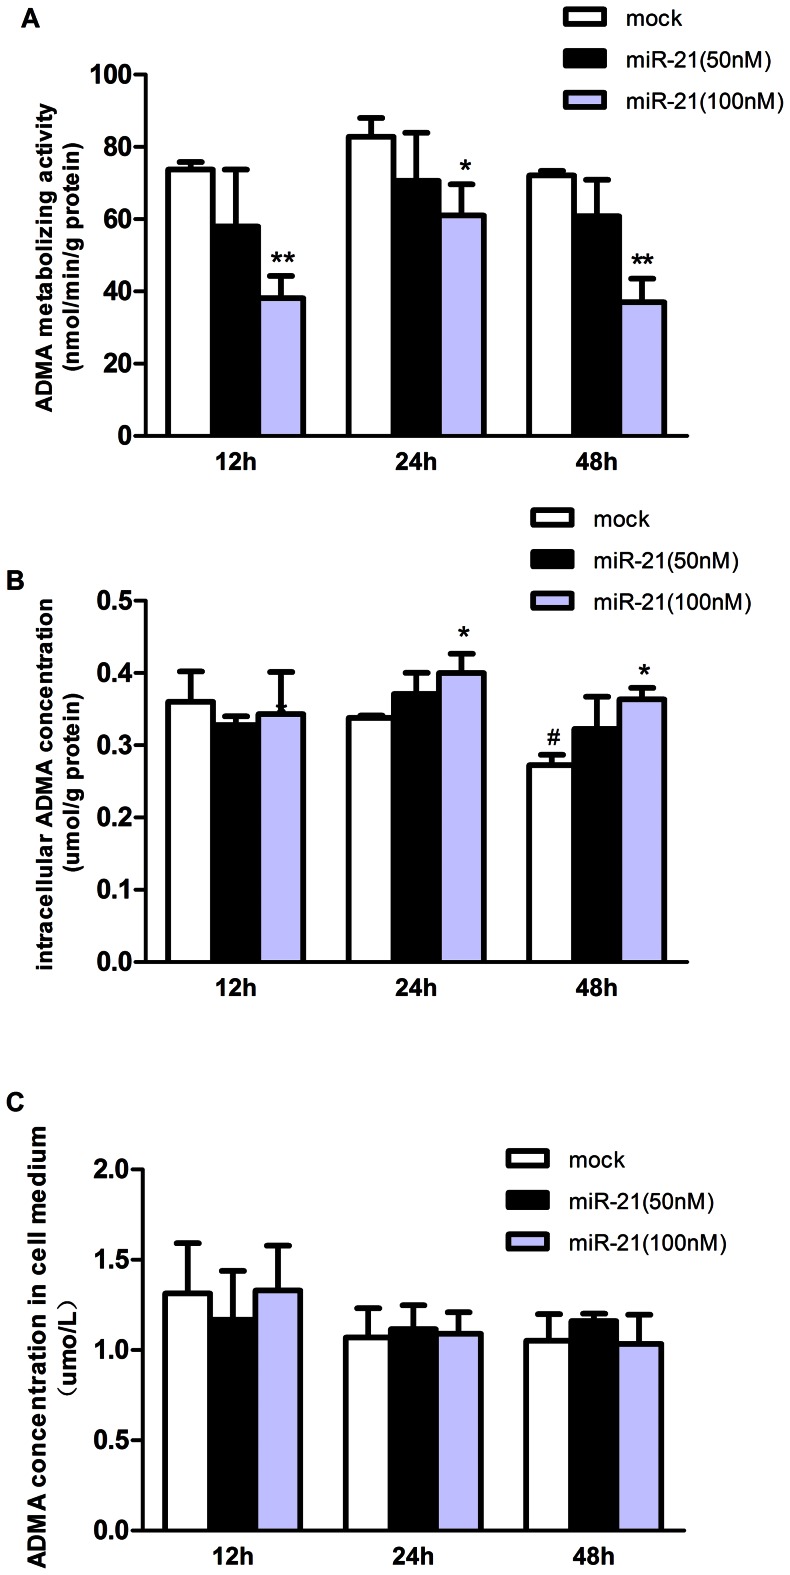
Influence of miR-21 transfection on intracellular ADMA metabolic activity and ADMA concentrations in HUVECs.Data were expressed as means±SEM (n = 3). A. ADMA metabolic activity of the cell lysates after miR-21 transfection. *p<0.05, **p<0.01, as compare with control group at corresponding time point; B. Intracellular ADMA concentration after miR-21 transfection. *p<0.05, as compare with control group at corresponding time point; #
p<0.05 compare with control group at 12 h; C. Concentration of ADMA in cellular medium after miR-21 transfection.